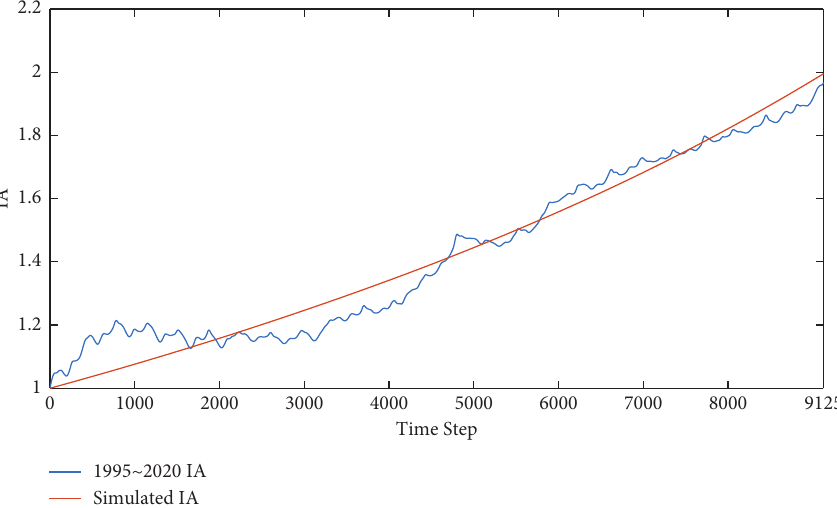
Figure 6: Comparison of real inflation operator and simulated inflation operator from 1995 to